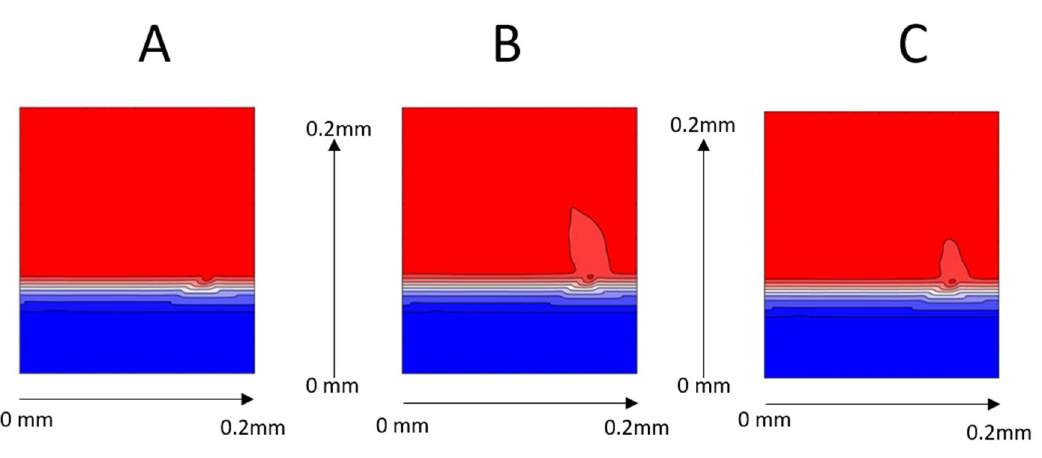
Figure 5. Two-dimensional slides of time-averaged DNS results of statistically planar premixed flames in cases ( A – C ). The colour range for filtering of flame fronts is from 1000 K (blue) to 3000 K